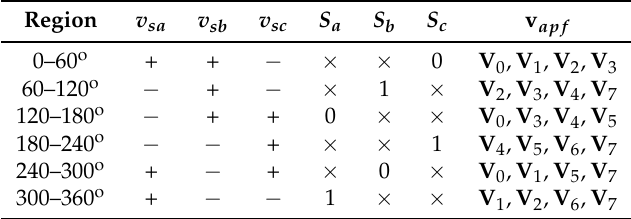
Table 2. Pre-selection voltage vectors for each